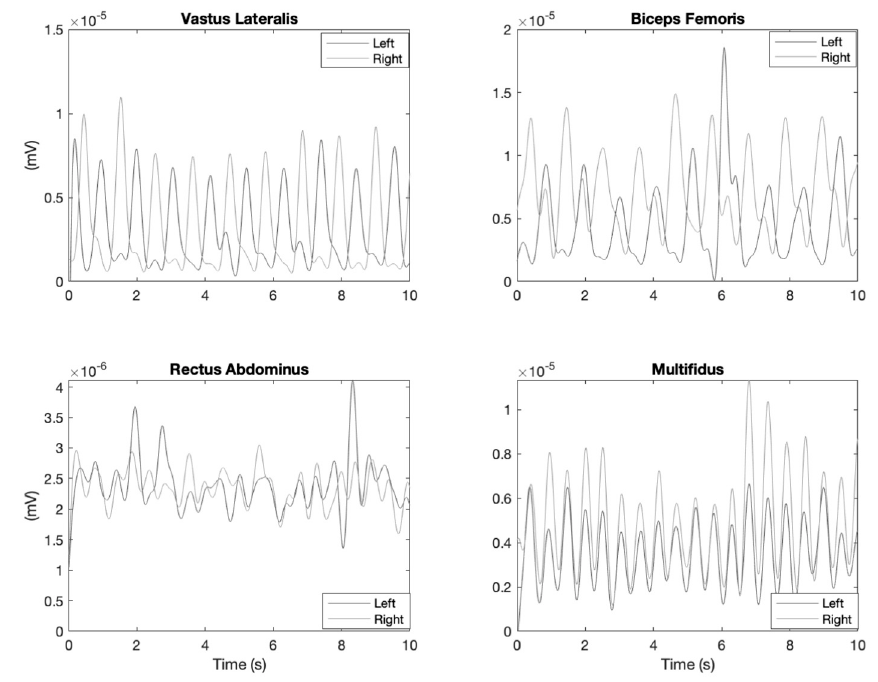
Figure 3. Representative processed surface electromyography from a single subject for a law enforcement belt walking trial. Only 10 of 30 s of collected data are shown to enhance the clarity. During processing, surface electromyography data were full-wave rectified and bandpass filtered (20 to 490 Hz) with a 4th order Butterworth filter. The rectified sEMG data were then smoothed using a 5 Hz low pass 4th order Butterworth filter.